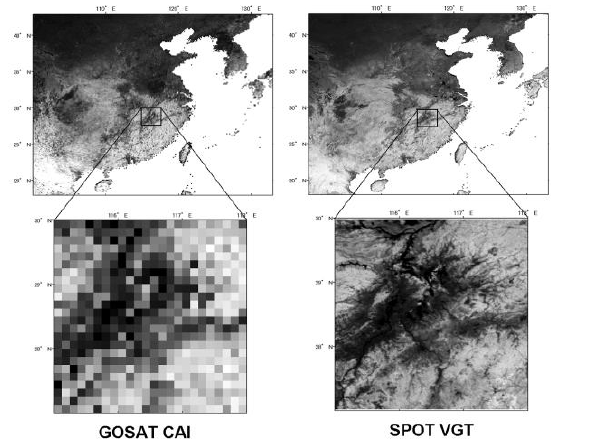
Figure 2. 10–day composite GOSAT CAI and SPOT VGT NDVI subsets at full spatial extent for an example site.